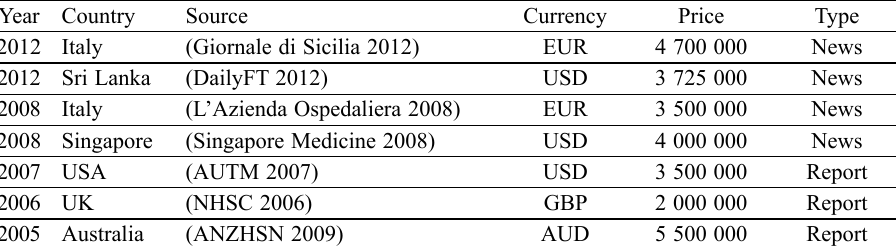
Table 2. Other data on estimated prices of tomotherapy units